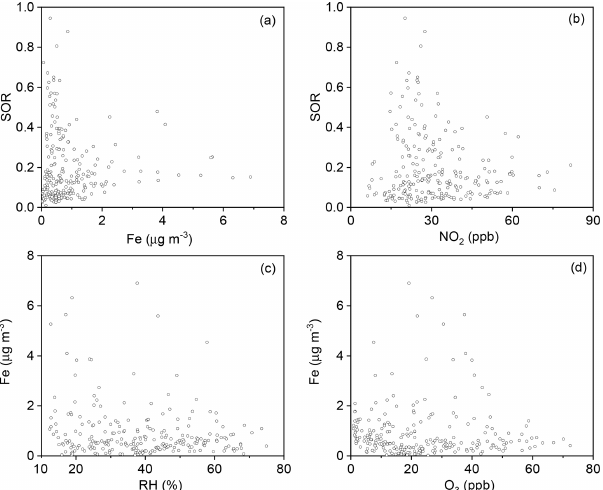
Figure 8. Plots of SORs against (a) Fe and (b) NO 2 . Plots of Fe against (c) RH and (d) O 3 . Data for days with rain or snow were excluded from these